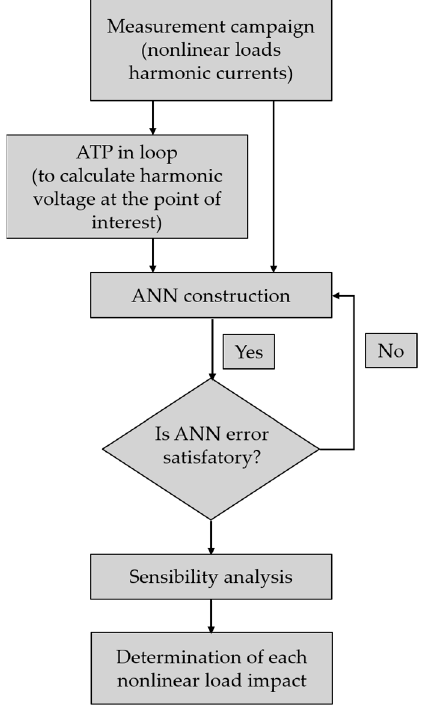
Figure 3. Simplified flowchart diagram.